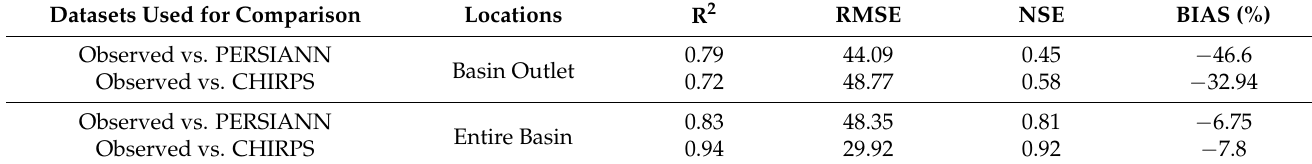
Table 4. Statistical parameters obtained after validation of CHIRPS and PERSIANN precipitation datasets with the Indian Meteorological Department (IMD) precipitation data at a single location (outlet of the basin) and for the entire basin (average of the different locations) in the basin.